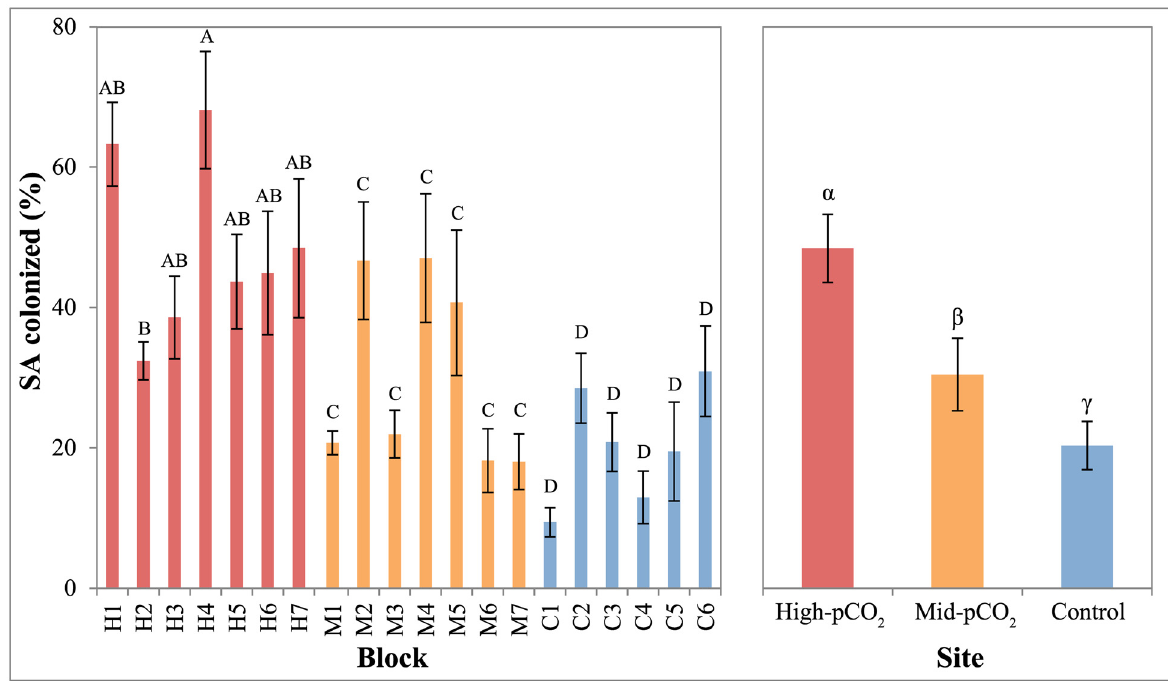
calculated among individual measurements within each block (5 measurements per blocks, 6 – 7 blocks per site) and among all measurements within each site (30 – 35) in the left and right panels, respectively.